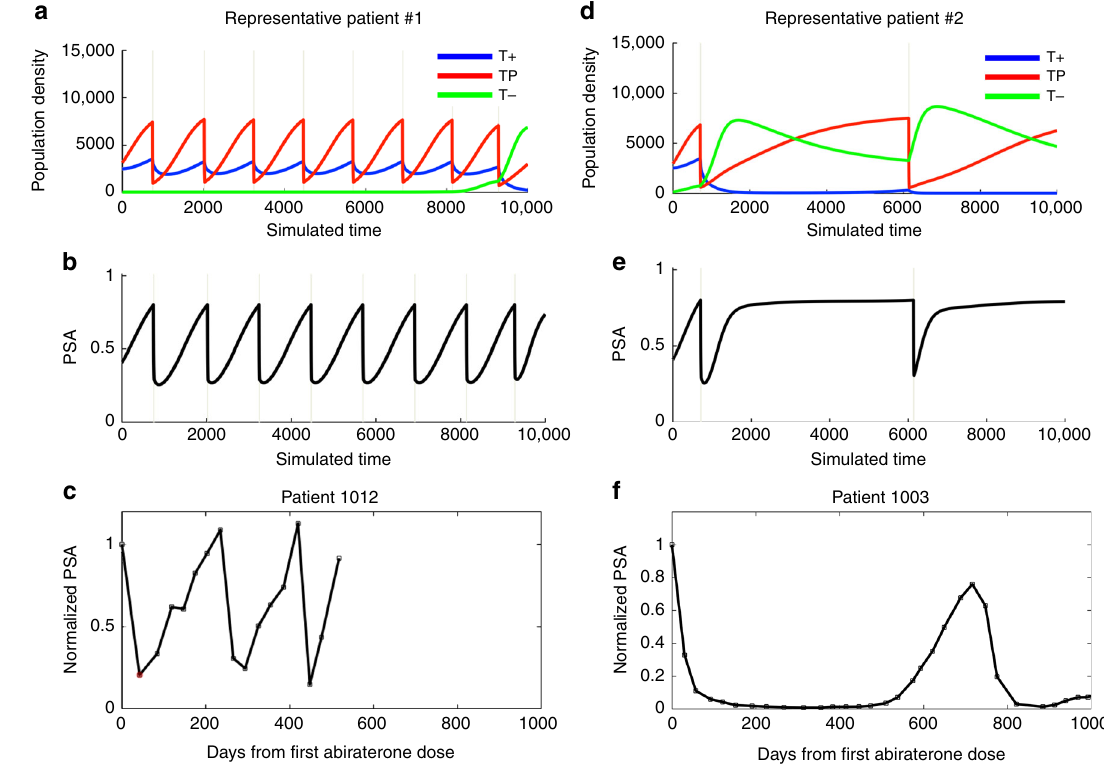
Fig. 4 a , b , d , and e show computer simulations demonstrating variation in cycle length. Time between treatments is shown to vary based on the competition coef fi cients of the matrix and the resulting prevalance of T+ cells. Panels a and b show Patient #1 ’ s fast cycling dynamics as the large T+ population contributes to the PSA reaching the treatment PSA level quickly. The durable control of T − cells is provided by the TP cell population. Alternately, panels d and e Patient #2 shows a low density of T+ cells resulting in long cycles. The variation in patient cycling rates explains the limitation of intermittent therapies administered without synchronization with underlyling evolutionary dynamics. Panels c and f show actual PSA fl uctuations in two of the clinical trial patients with associated abiraterone administration. The fi rst dose of abiraterone is given at day 0. In each case, the PSA is normalized to its value on day 0. The drug is withdrawn when the PSA falls below 50% of the original value. It is withheld until the PSA returns to its initial value (corresponding to the PSA peaks). This explicit incorporation of Darwinian principles into treatment allows drug administration to synchronise